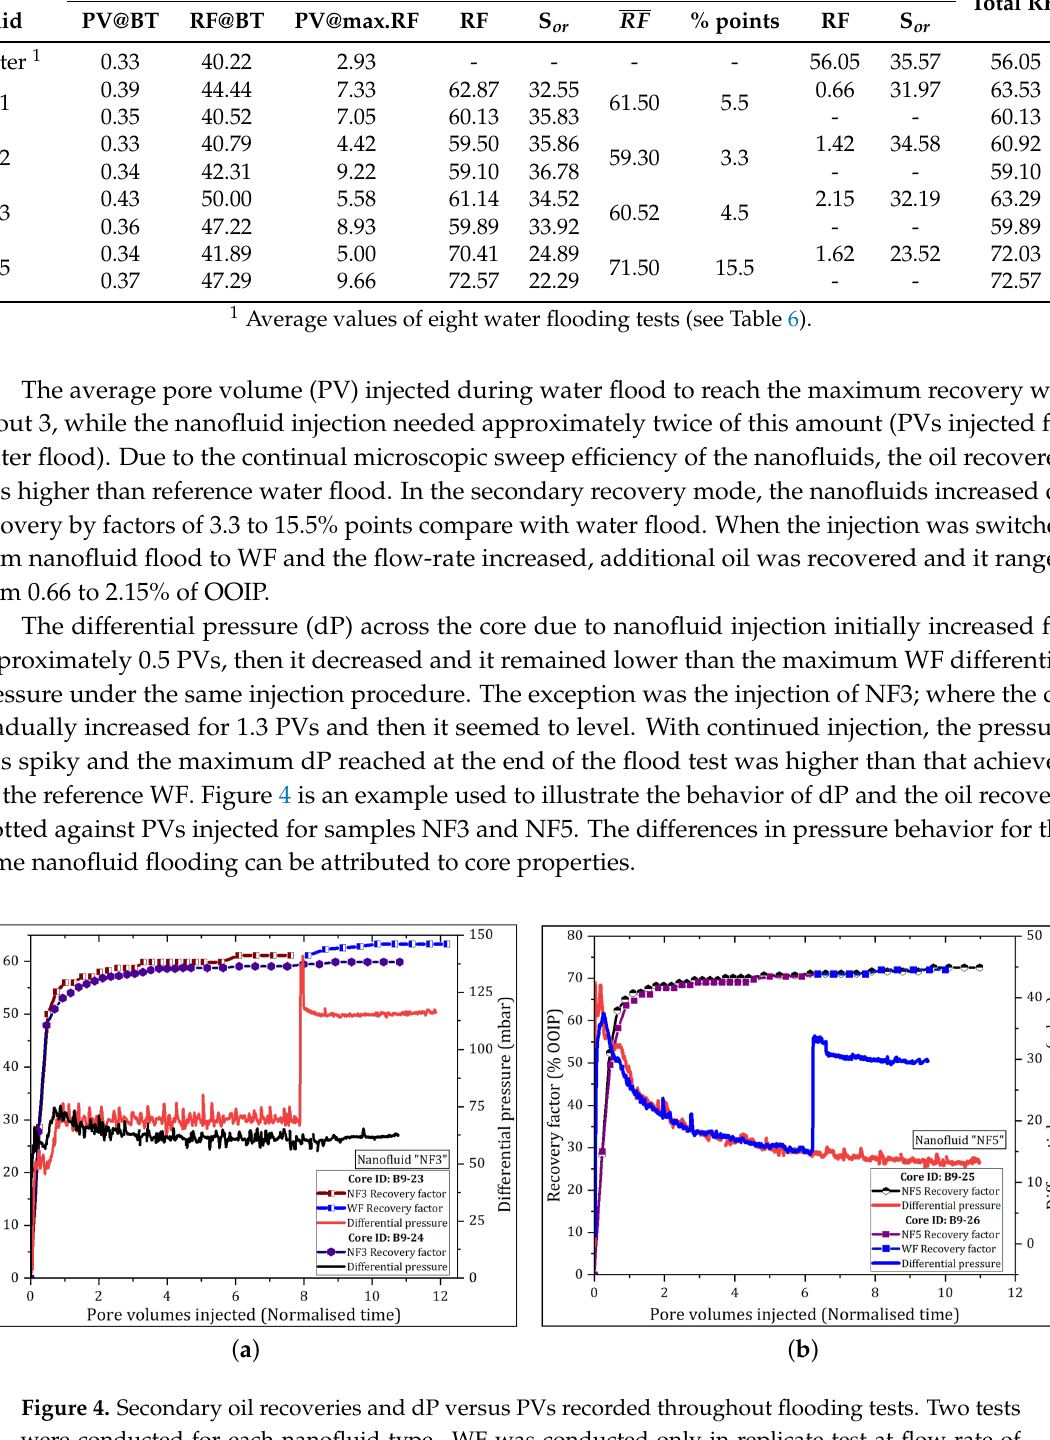
Table 5. Oil recovery factors (water and nanofluid flooding), expressed as percent of OOIP, and residual oil saturation achieved at the end of core flooding in neutral-wet cores. Injected Nanofluid Flood